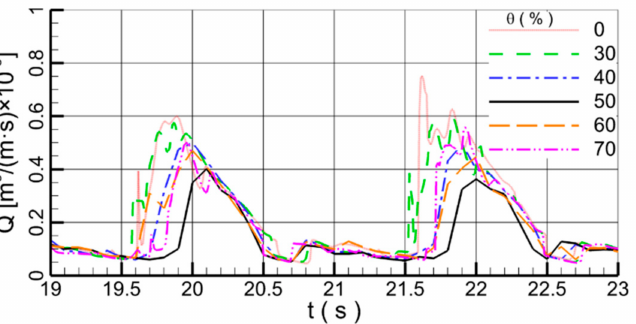
Figure 14. Temporal evolution of the wave overtopping volume for different gap